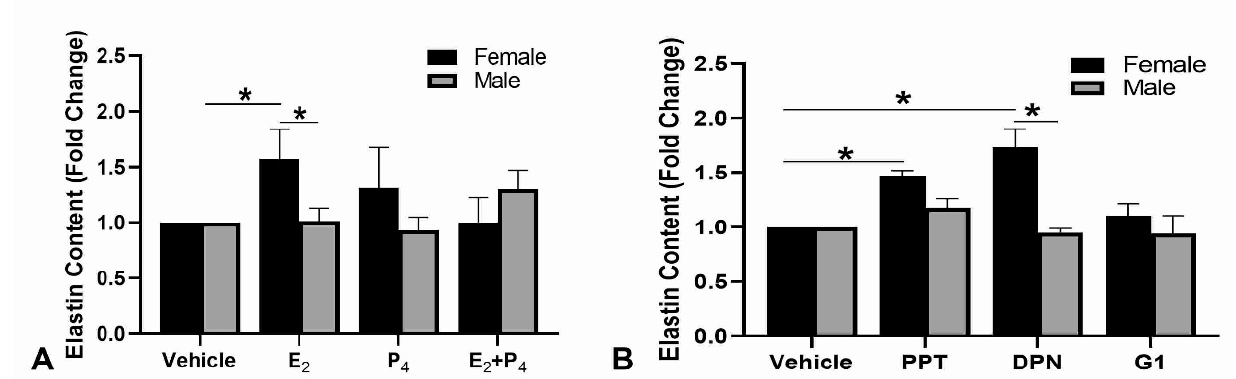
Figure 1. Elastin content of EDS. ( A ) Culture with E 2 alone significantly increased elastin content in the female, but not the male EDS. ( B ) Culture with agonists specific for either ER- α (PPT) or ER- β (DPN) significantly increased elastin content in female EDS. Agonists to GPER-1 (G1) did not have a significant effect. n = 5, * indicates p < 0.05.